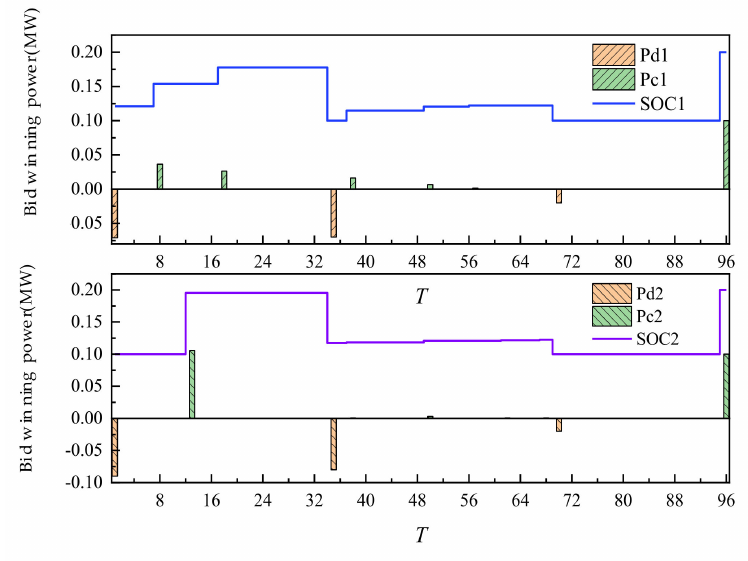
Figure 15. Intra-day trading of